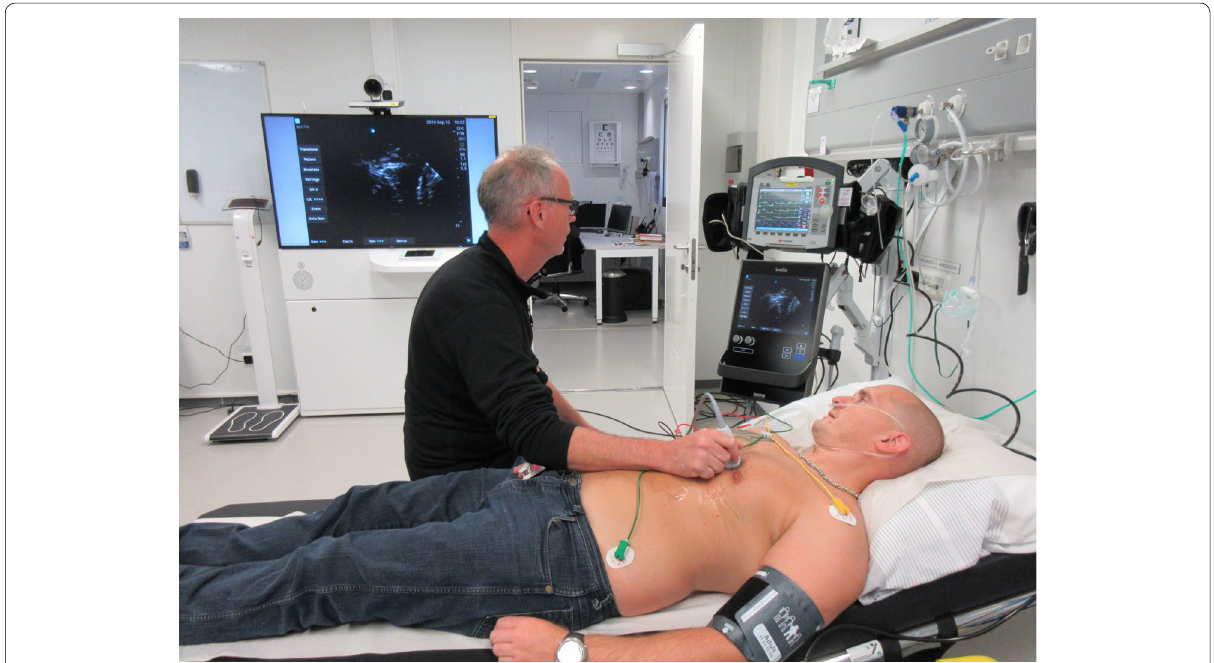
Fig. 5 Telementored ultrasound from the Aasta Hansteen platform in the Norwegian Sea. This oil installation is 300 km from the Norwegian coast, remote from other installations and in an area with extreme weather conditions. Its modern hospital is equipped with a wall-mounted SII Sonosite ™ ultrasound machine (bottom) and Corpuls 3 ™ monitor/defibrillator machine (top), connected to the Medical unit in the background. Telementored ultrasound and live transfer of patient data such as ECG, blood pressure and saturation, make it possible for physicians to monitor and diagnose critically ill and injured patients from onshore hospitals in Norway. Photo: Svein